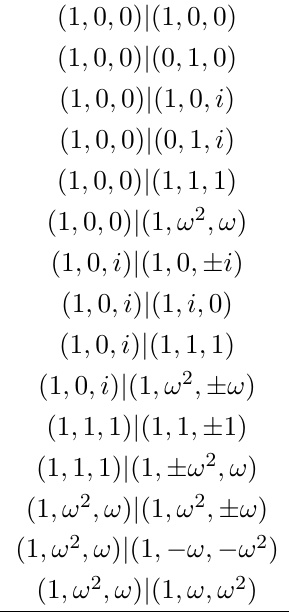
Table 3 . List of VEV directions for the potential of two triplets of S 4 , V S